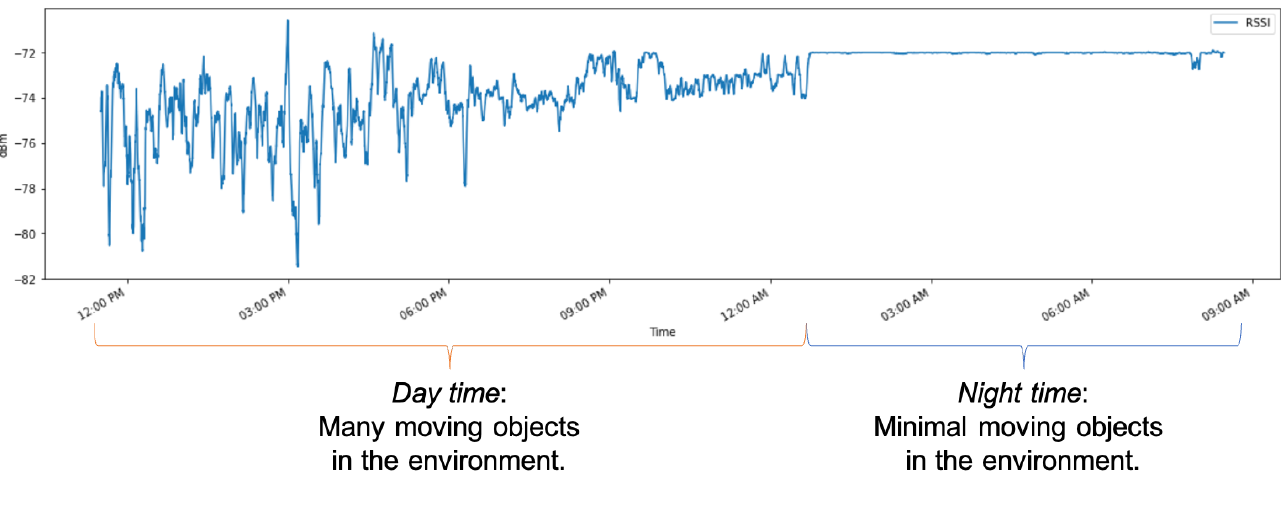
Figure 9. s ’ RSSI stream as received by r during s ’ deployment inside of the property.